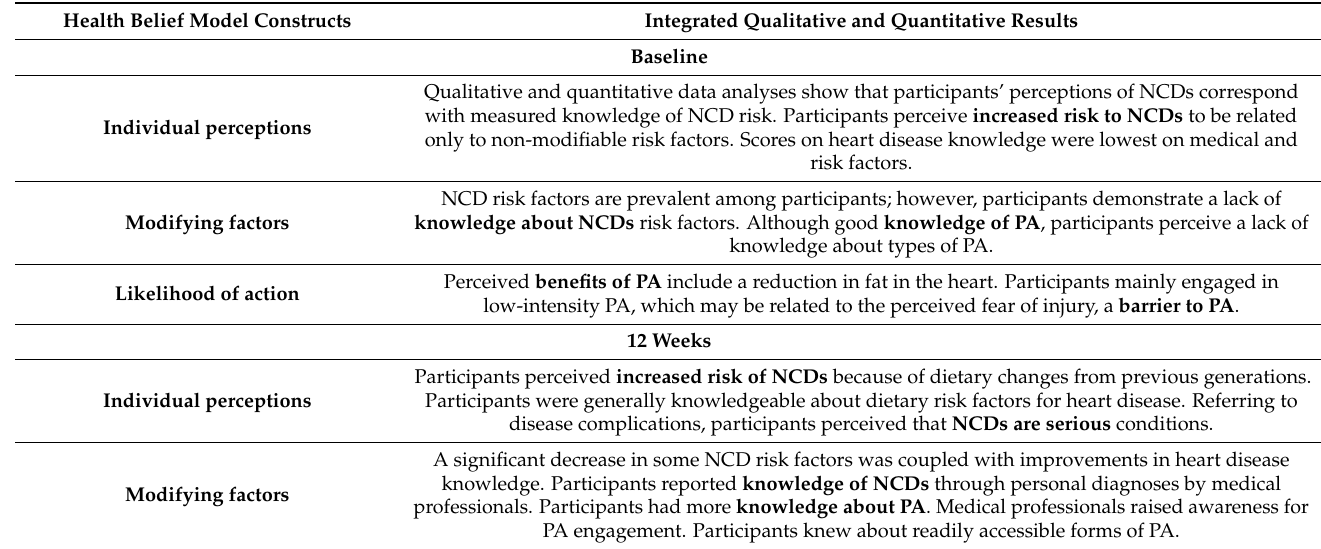
Table 6. Integration of qualitative and quantitative